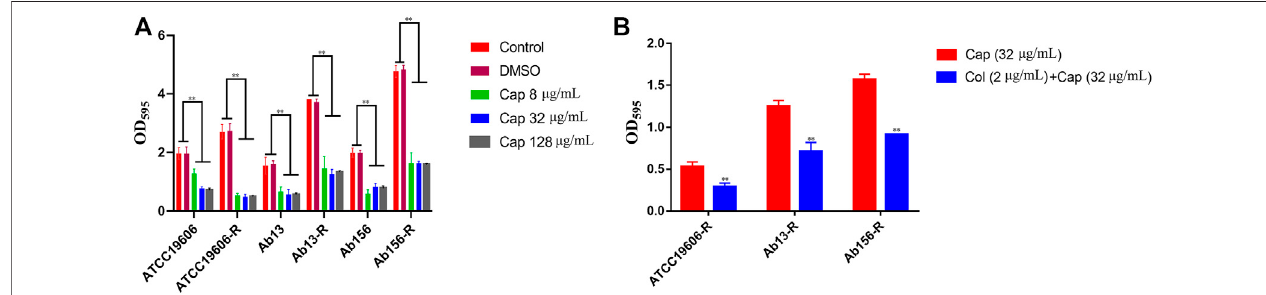
FIGURE4|(A) :Effect ofcapsaicin (0 – 128 μ g/mL) onbio fi lmformationof A.baumannii. (B) :Thecombinationofcolistin(2 μ g/mL) and capsaicin (32 μ g/mL) onthe bio fi lm formation of A. baumannii. * p < 0.05, ** p < 0.01, data are expressed as the mean ± SD of three